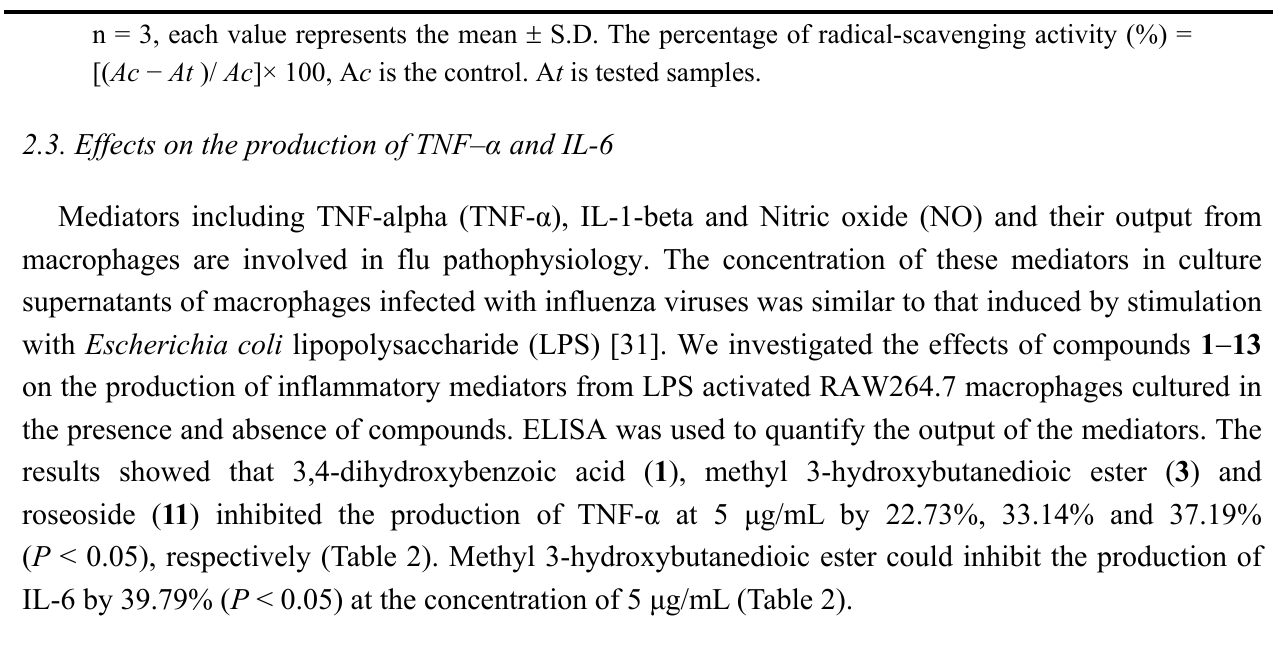
Table 2. Inhibitory effects of components on the production of TNF- α and IL-6 in